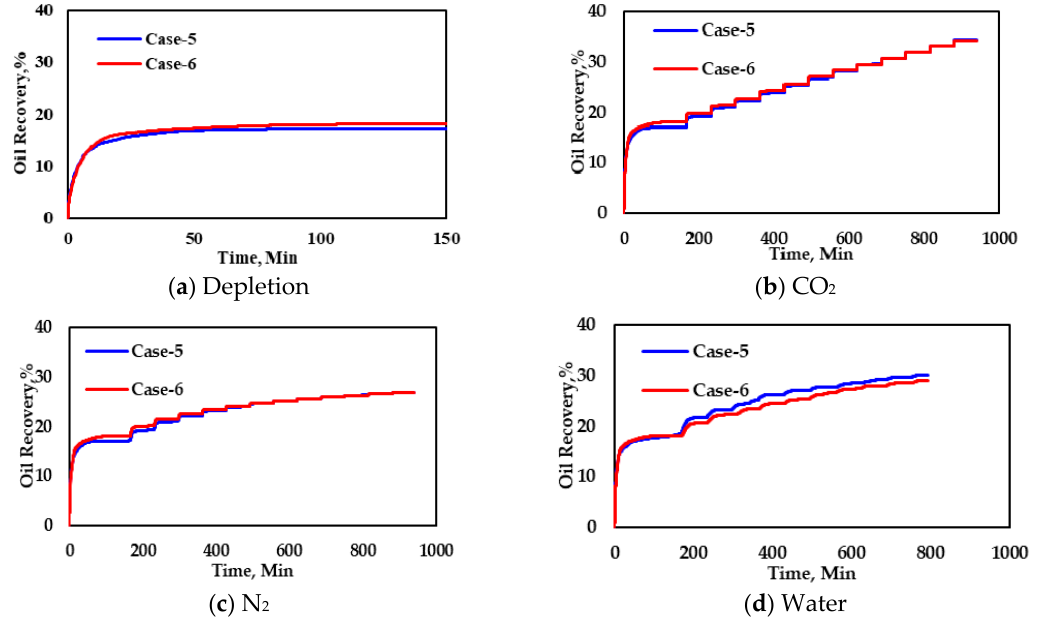
Figure 32. Oil recovery comparison between fractures near well and far well.